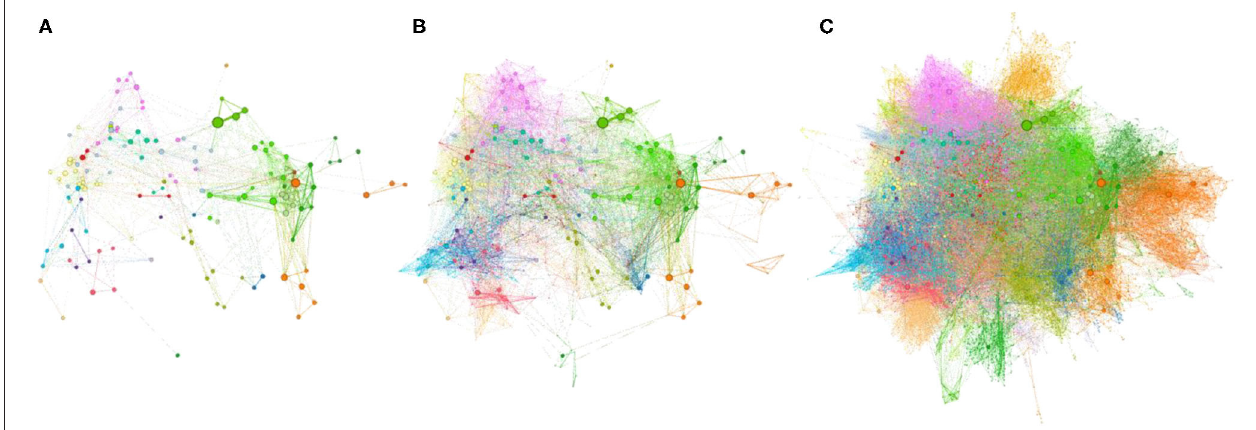
FIGURE 3 | Collaborative networks of inventors in semiconductor-related patents from 1980 to present. Clusters of frequently co-occurring coinventors are represented in different colors. The size of the node is relative to the number of patents per inventor. From left to right: (A) star researchers; (B) star researchers and NSR-A1; (C) all researchers in the